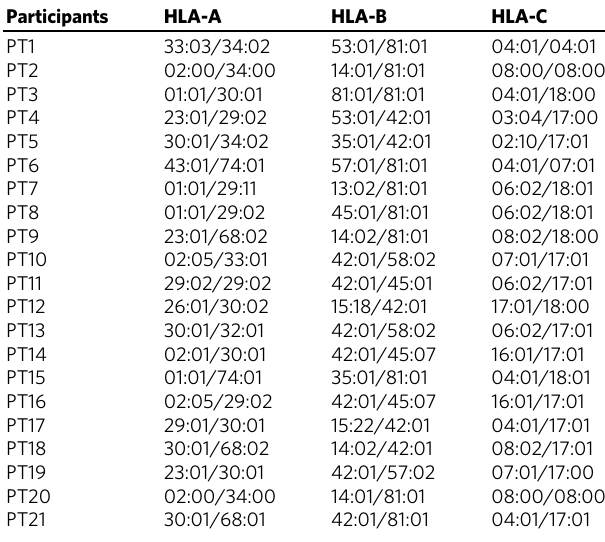
Table 2 Detail class I HLA pro fi les of the study participants